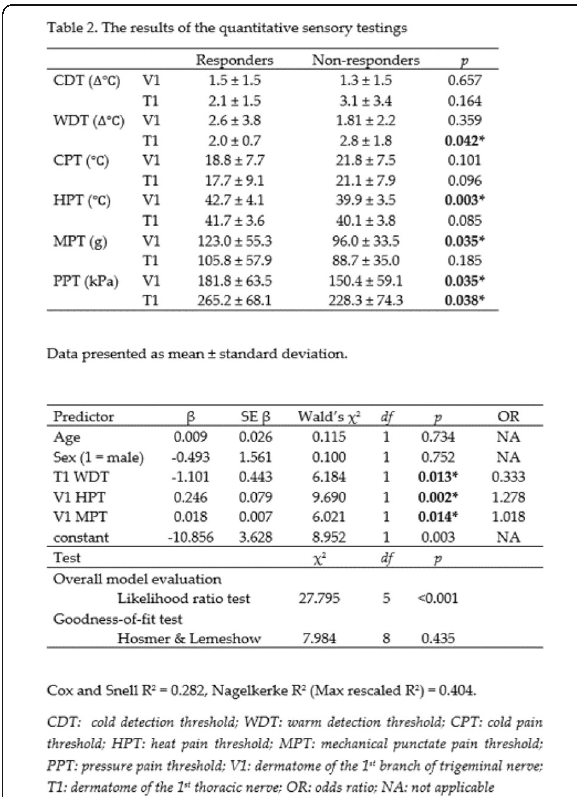
Table 2 (abstract AL013). See text for description